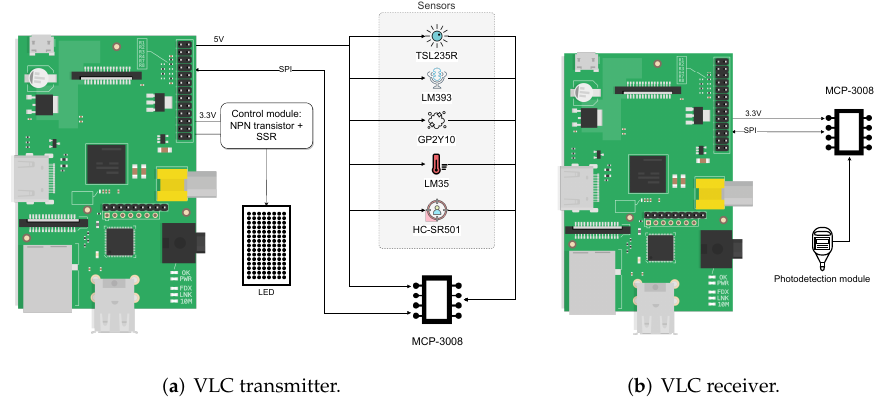
Figure 5. Architecture of the VLC